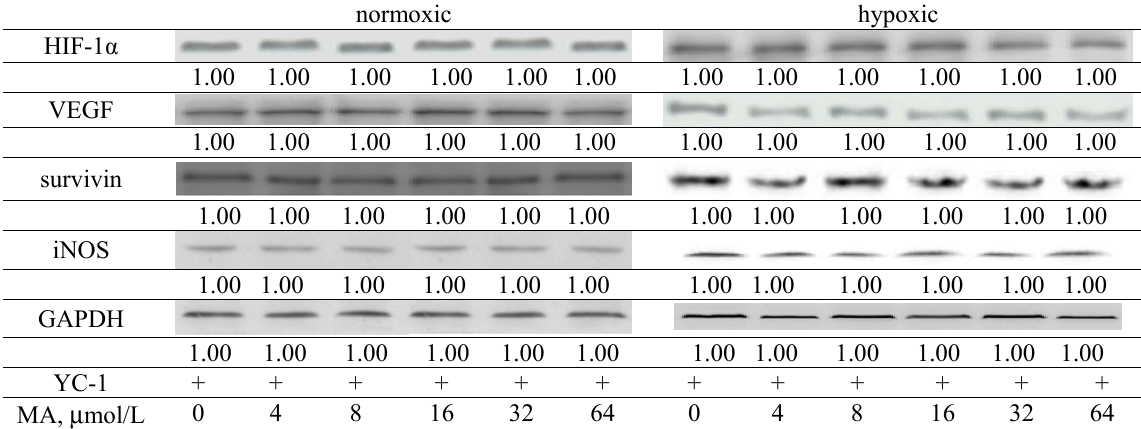
Figure 7. Effects of YC-1 and MA at 0, 4, 8, 16, 32 or 64 μ mol/L upon HIF-1 α , VEGF, survivin and iNOS expression in A549 cells under normoxic and hypoxic conditions. Data are mean ± SD ( n = 10).